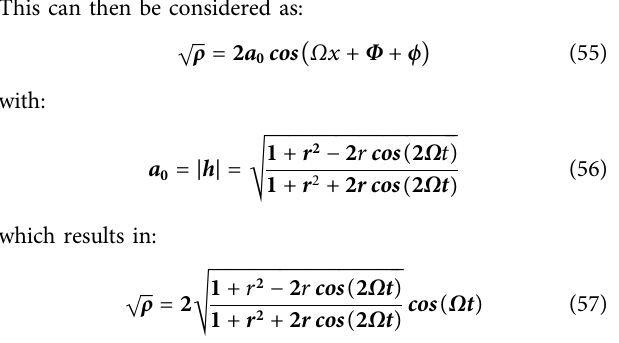
Frontiers in Earth Science |